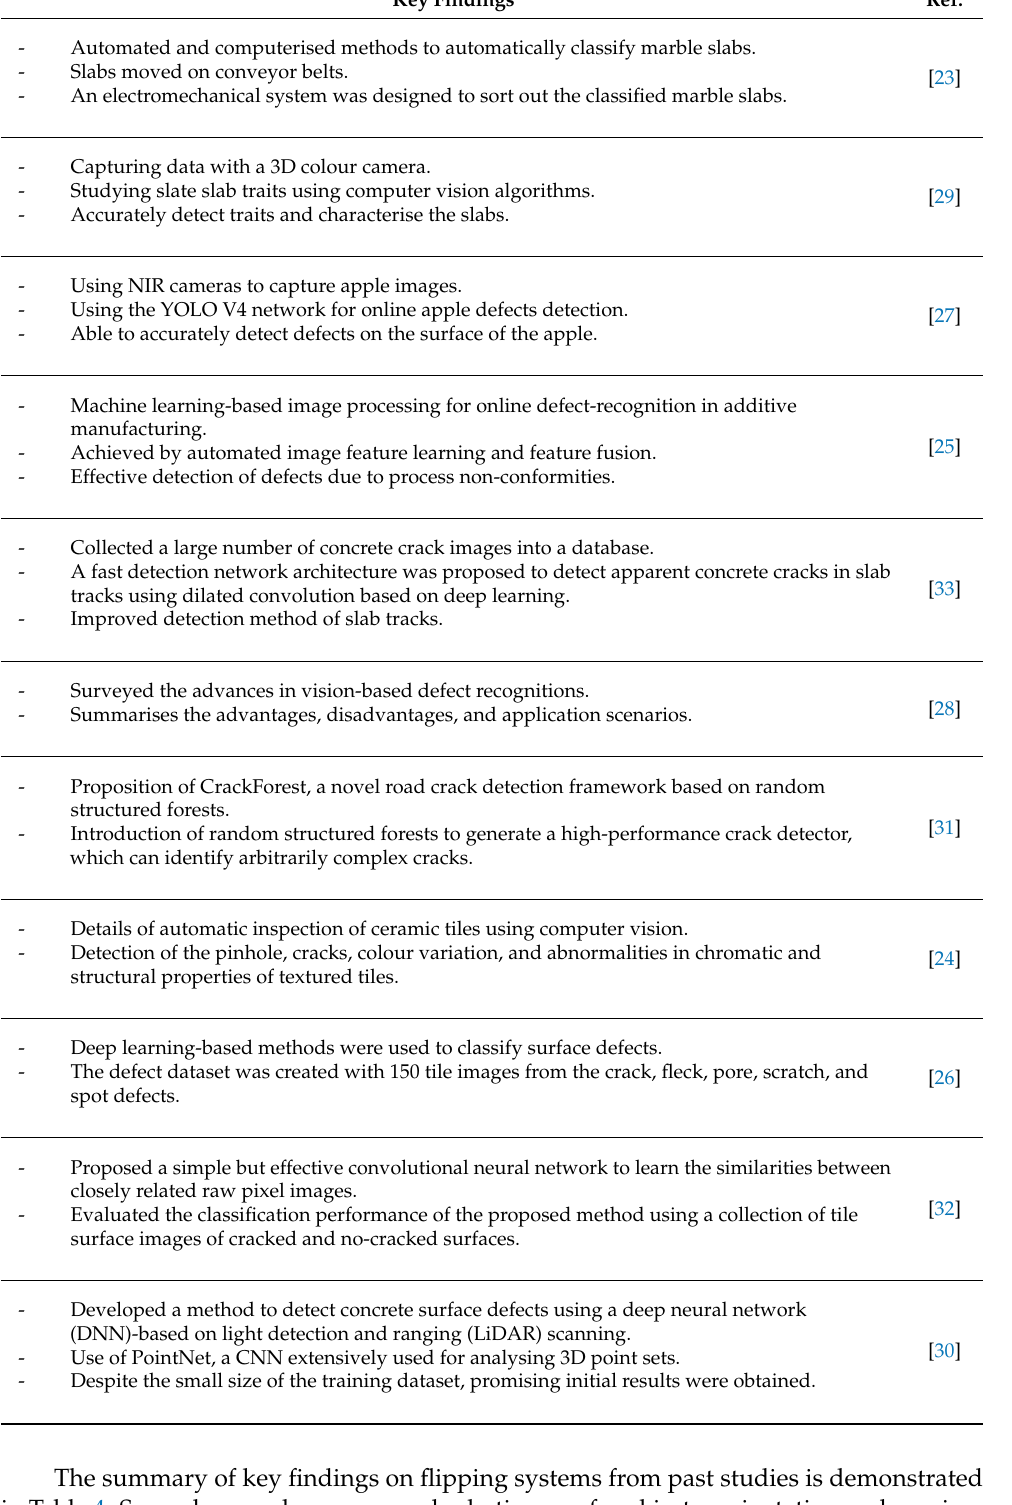
Table 3. Summary of key findings of past studies on inspection systems. Key Findings